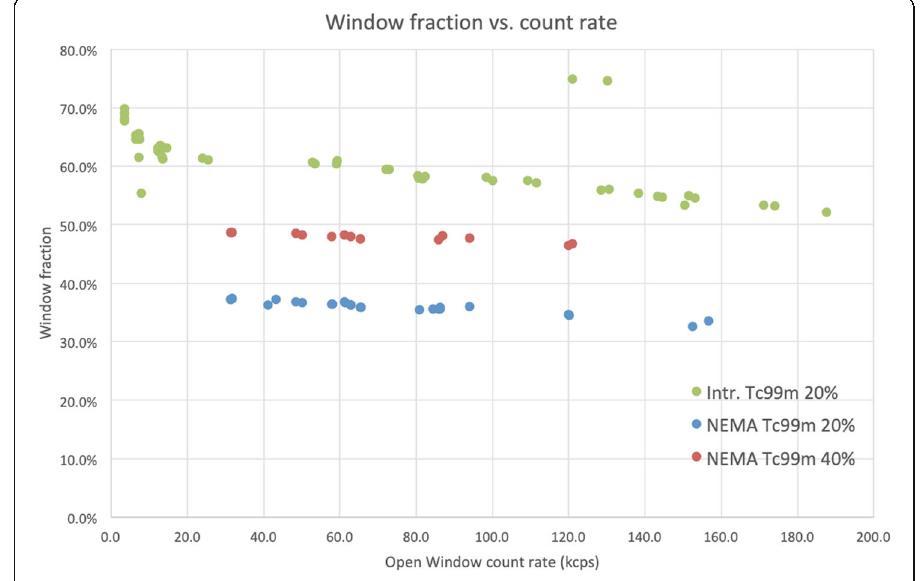
Fig. 9 Window fraction (i.e., 99m Tc counts/OW counts) plotted vs. open window count rate for the intrinsic measurement and the second extrinsic measurement with the NEMA scatter phantom for both 20% and 40% 99m Tc energy window width. Green, intrinsic measurement 20% 99m Tc energy window; blue, NEMA phantom measurement 20% 99m Tc energy window; red, LEHR NEMA phantom measurement 40% 99m Tc energy window. The 40% energy 99m Tc window is not available for all